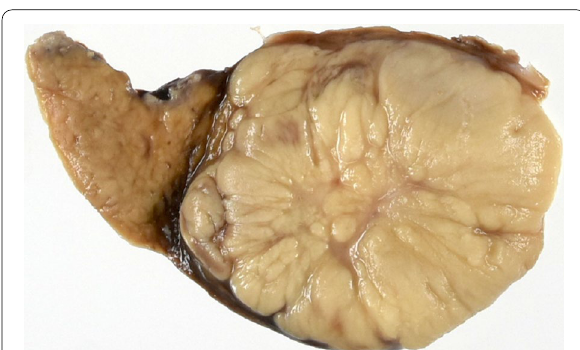
Fig. 3 Macroscopic findings of the tumor. The whitish tumor with a maximum diameter of 4.0 cm was simple nodular type and showed expansive